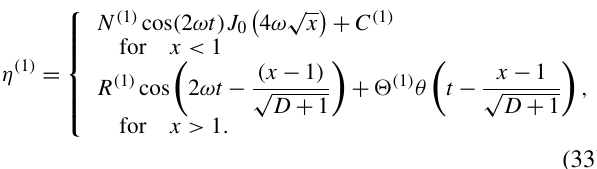
Figure 6. Run-ups normalized to the amplitude of the incident wave for Model-1. The incident wave is in the form η = η I √ √ √ D + 1 ))θ(t + (x − 1 )/ D + 1 ) tanh (t + (x − 1 )/ D + 1 ) . The frequency of the incident wave is (cid:60) ω 1 (D = 0 ) . The blue continuous 1 )/ curve is the linear run-up. The dashed–dotted green curve includes nonlinear effects associated with CG transform ( r = ∂ λ ϕ − 0 . 5 u 2 s and t = λ + u s ). The amplitude of the incident wave is 1 / 15. Nonlinear effects due to the boundary condition at the toe of the slope have been